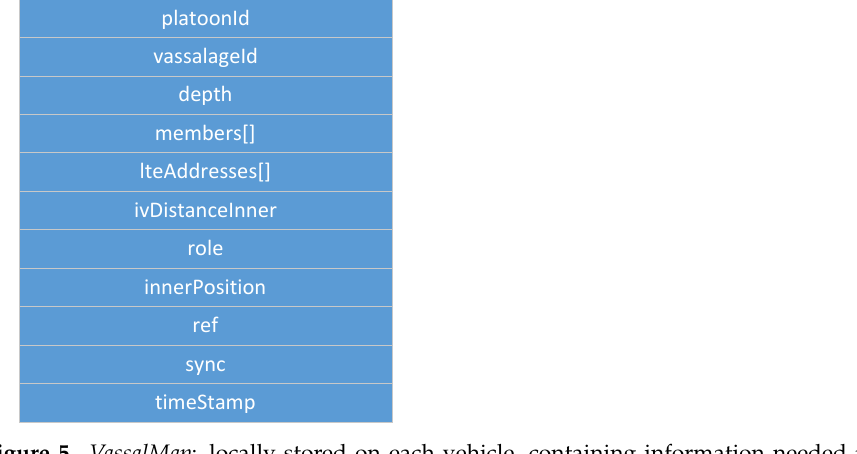
Figure 5. VassalMap : locally stored on each vehicle, containing information needed to perform Feudalistic Platooning